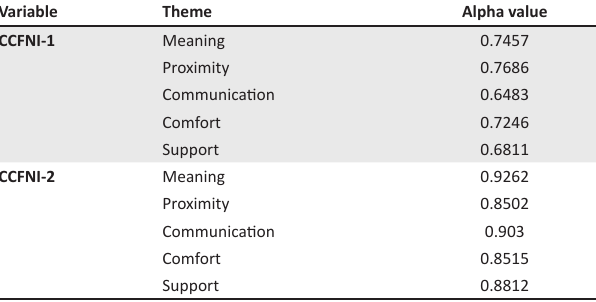
TABLE 1: Results Cronbach alpha test.